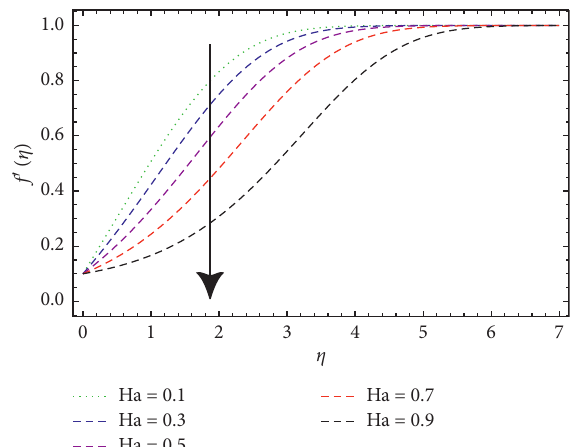
Figure 7: Influence of the velocity f ′ ( η ) profile via Ha.